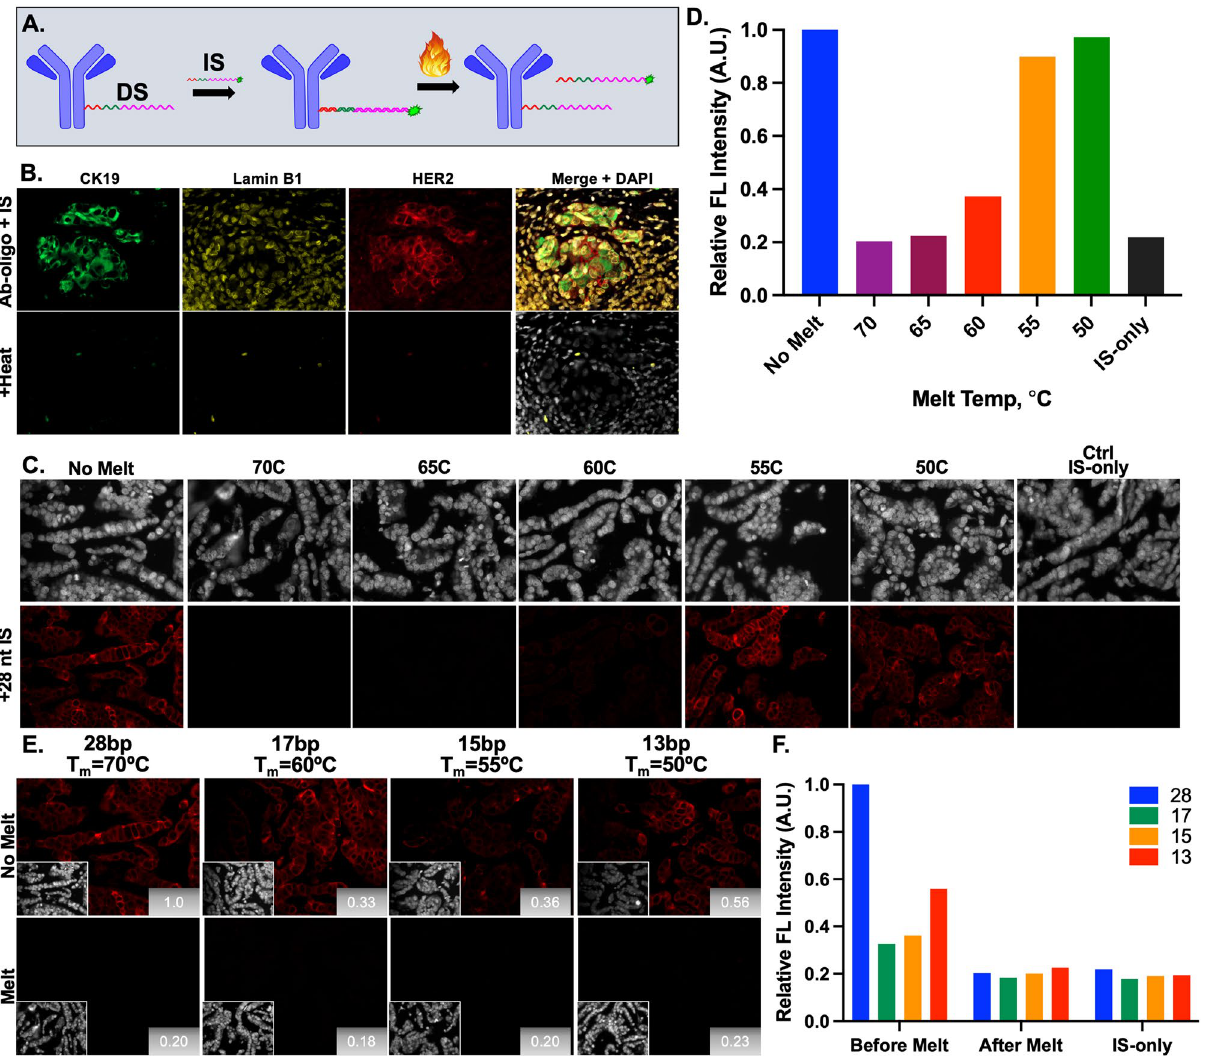
Figure 5. Thermal denaturation signal removal. ( A ) After Ab-oligo conjugate staining with a fluorophore labeled IS, signal removal was achieved by heating the slide to a temperature above the IS-specific T m to denature the DS/IS complex, where the IS was readily washed from the sample. ( B ) Heating of a tissue section stained with Ab-oligo conjugates for CK19, Lamin B1 and HER2 to 70 °C resulted in full removal of marker specific staining. ( C ) Tissues stained with the CK19 Ab-oligo conjugate were exposed to varied temperatures to find a minimum temperature needed to denature 28 nt DS/IS pairs, where ( D ) relative fluorescence intensity at each temperature was quantified. ( E ) Tissues stained with CK19 Ab-oligo conjugate were incubated with IS of varying length and then heated to the T m specific to each DS/IS pair, which decreased with IS length. ( F ) Relative fluorescence intensity was quantified for each length IS before melting, after melting and for the IS-only temperature was required to reduce the fluorescence intensity to the level of IS-only stained tissues (Fig. 5C,D). Based on these results, the temperature selected for optimization using thermal removal studies was ~ 5 °C above the calculated T m of each specific DS/IS pair. While heating to at least 65 °C successfully denatured 28 nt DS/IS hybridization, there was concern that repeat heating to such high temperatures would damage tissue or remove antibodies from their bound antigen. To address this concern, shorter IS lengths of 17, 15 or 13 nt were compared to the 28 nt length used to detect the CK19 Ab-oligo conjugate. These studies allowed evaluation of staining specificity using shorter IS as well as signal removal using lower temperatures. Fluorescence signal intensity was the highest for the longest (i.e., 28 nt) tested IS, however all tested IS lengths provided specific CK19 staining. Fluorescence signal for DS/IS pairs of all lengths was readily reduced to IS-only levels after heating to denature DS/IS duplexes at ~ 5 °C above the calculated T m (Fig. 5E,F). To assess the utility of thermal denaturation for signal removal over multiple rounds of staining, a HER2+ breast cancer tissue was stained with CK19, Lamin B1 and HER2 Ab-oligo conjugates. In situ IS hybridization with either 28 or 13 nt length IS were used for detection (Fig. 6). The slides were subjected to six rounds of IS staining, imaging and fluorescence signal removal by heating at 70 and 50 °C for the 28 and 13 nt IS, respectively.